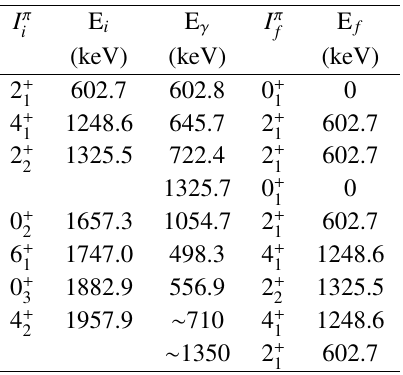
Table 2. Observed transitions in 124 Te. Level energies, spins and parities taken from Ref. [26].